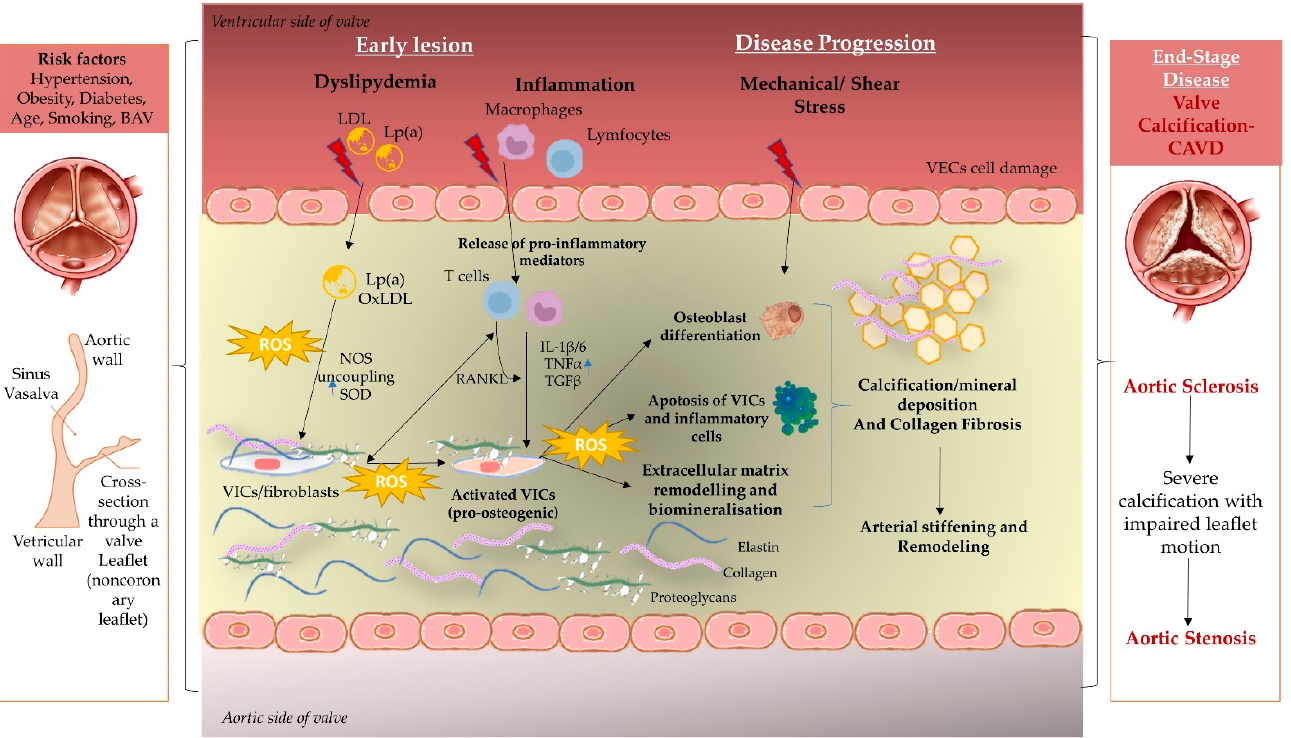
Figure 1. Contribution of oxidative stress in calcific aortic valve disease. Calcific aortic valve disease (CAVD); the bicuspid aortic valve (BAV); reactive oxygen species (ROS); low-density lipoproteins (LDL); lipoprotein (a) (Lp(a)); vascular endothelial cells (VECs); valvular interstitial cells (VICs); nitric oxide synthases (NOS); superoxide dismutase (SOD); receptor activator of NF- kB ligand superfamily member 11 (RANKL); transforming growth factor beta (TGF β ); tumor necrosis factor-alpha (TNF- α).